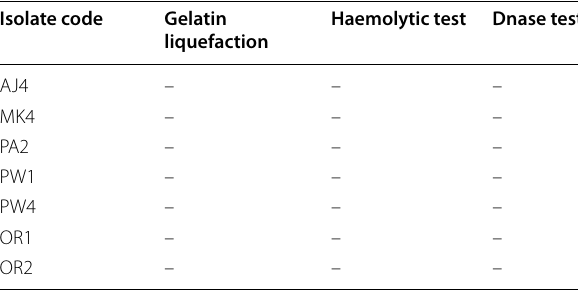
Table 2 Pathogenicity test of yeast isolates